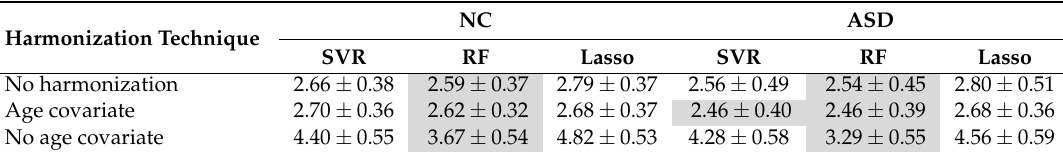
Table 2. Mean MAE ± SD resulting from age prediction for each class and each harmonization technique for the three regression algorithms SVR, Random Forest, and Lasso. The best performances are highlighted in gray.